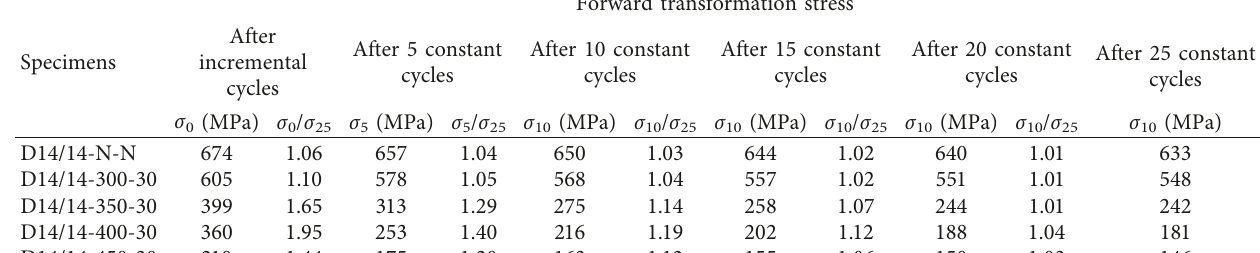
Table 3: Forward transformation stress at typical loading